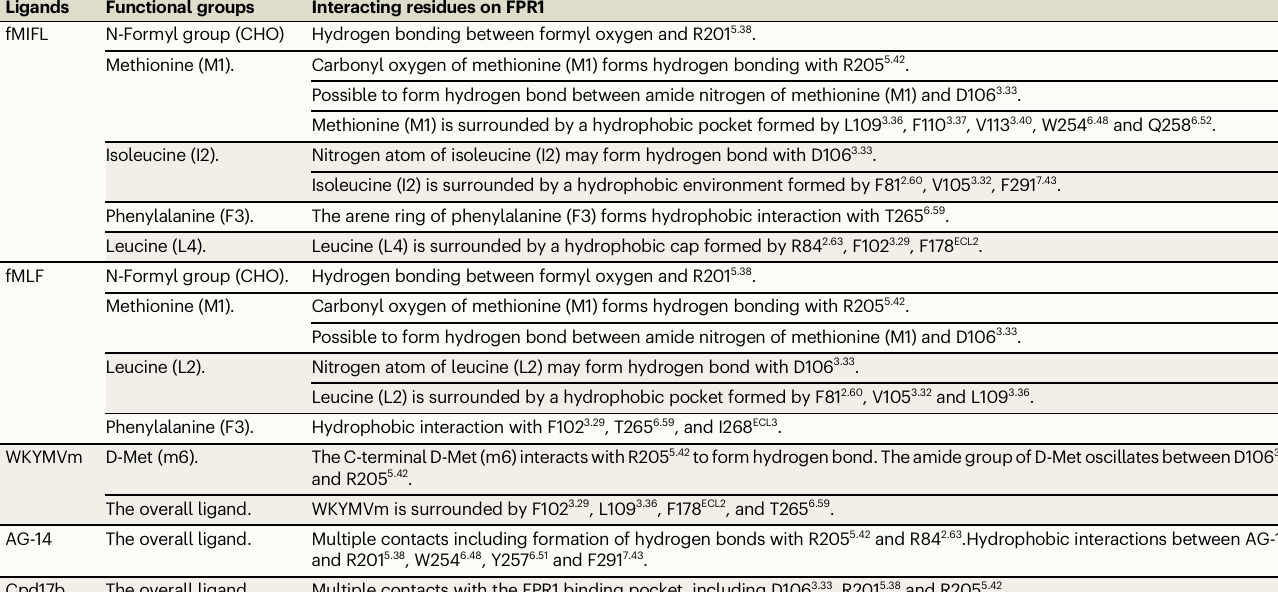
Table 2 | Summary of predicted interactions between selected ligands and amino acid residues of the FPR1 receptor within 4.5Å Ligands Functional groups Interacting residues on